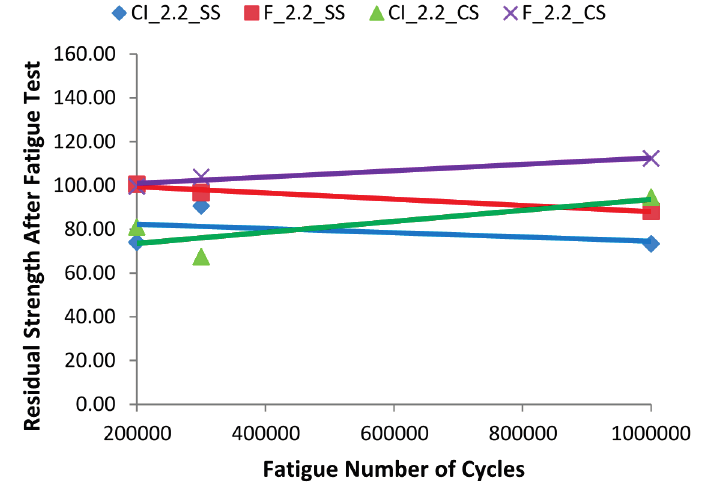
Figure 14. Percentages of residual strength after fatigue